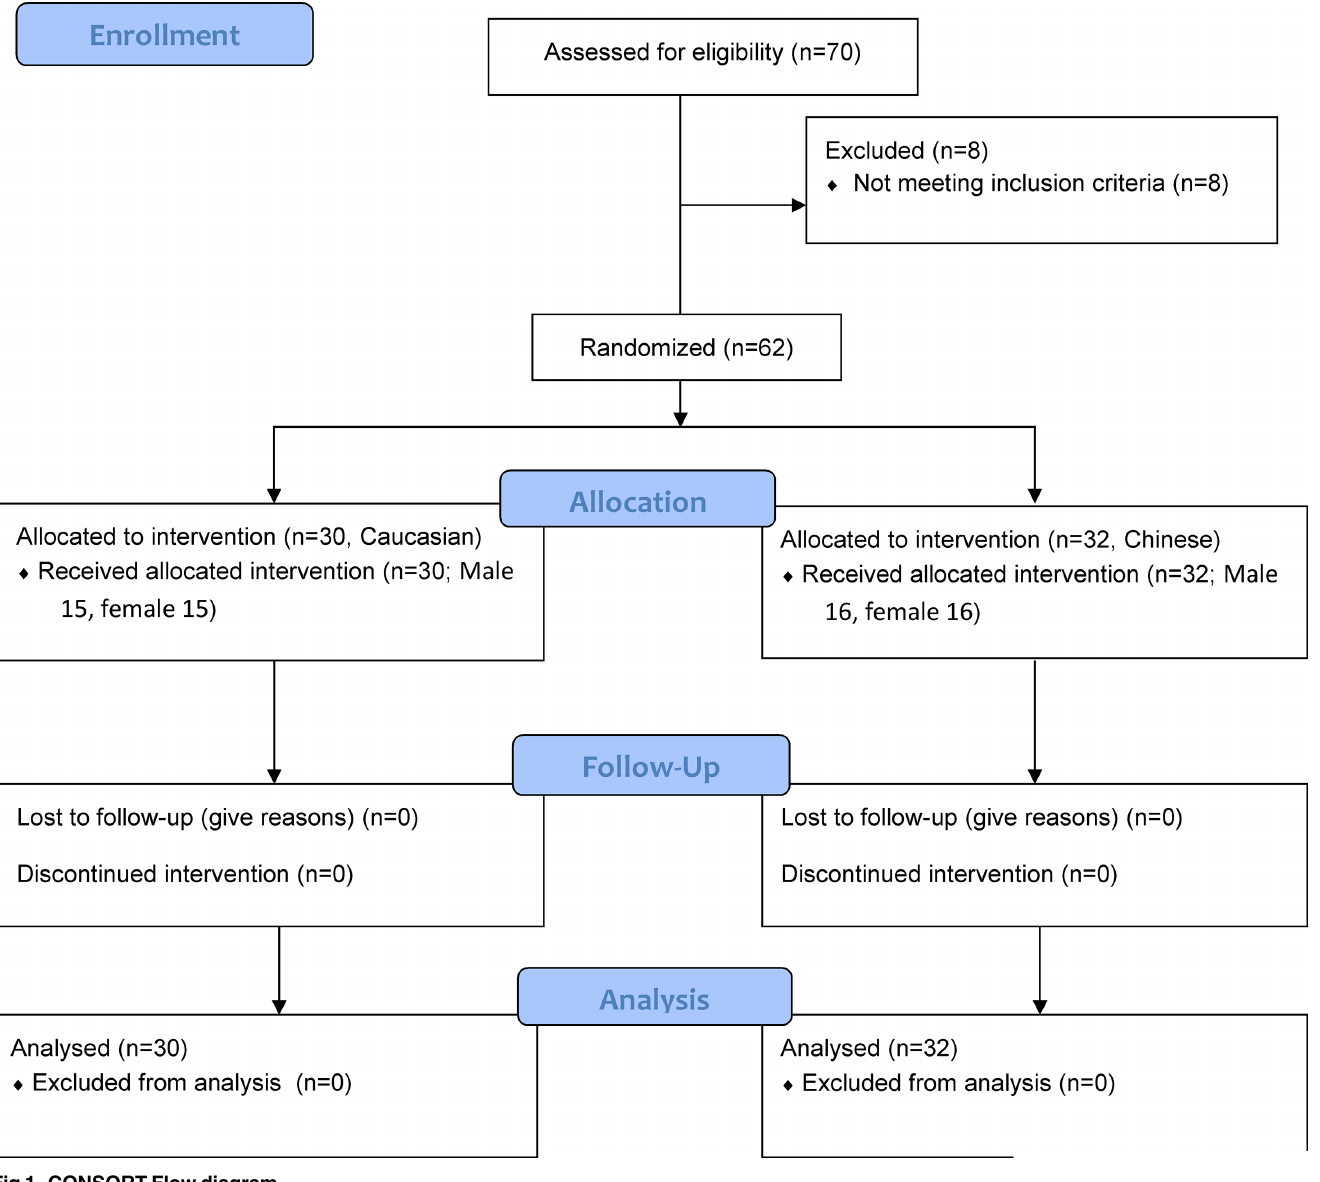
Fig 1. CONSORT Flow